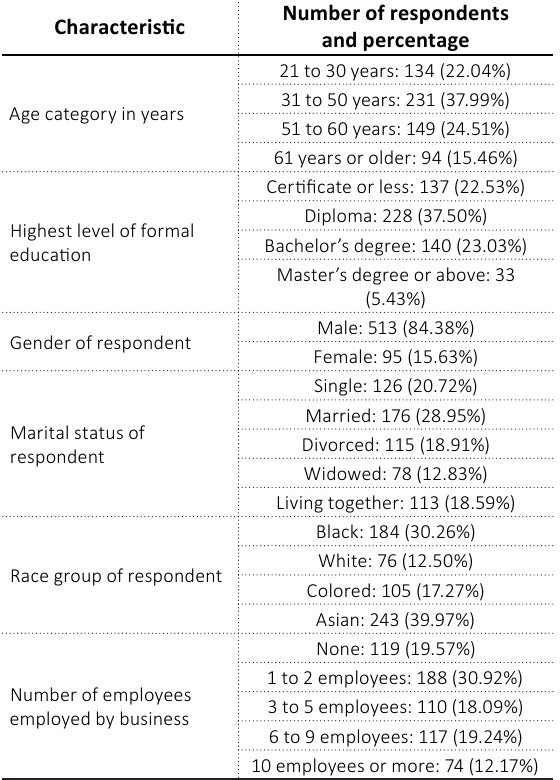
Table 2. Demographic characteristics